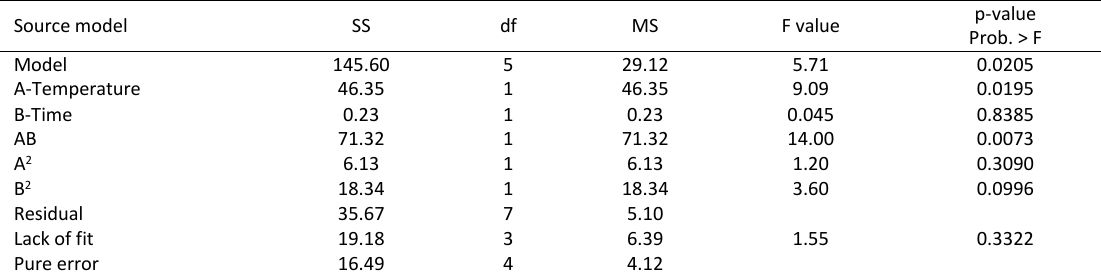
Table 3a: Analysis of variance (ANOVA) for biochar yield